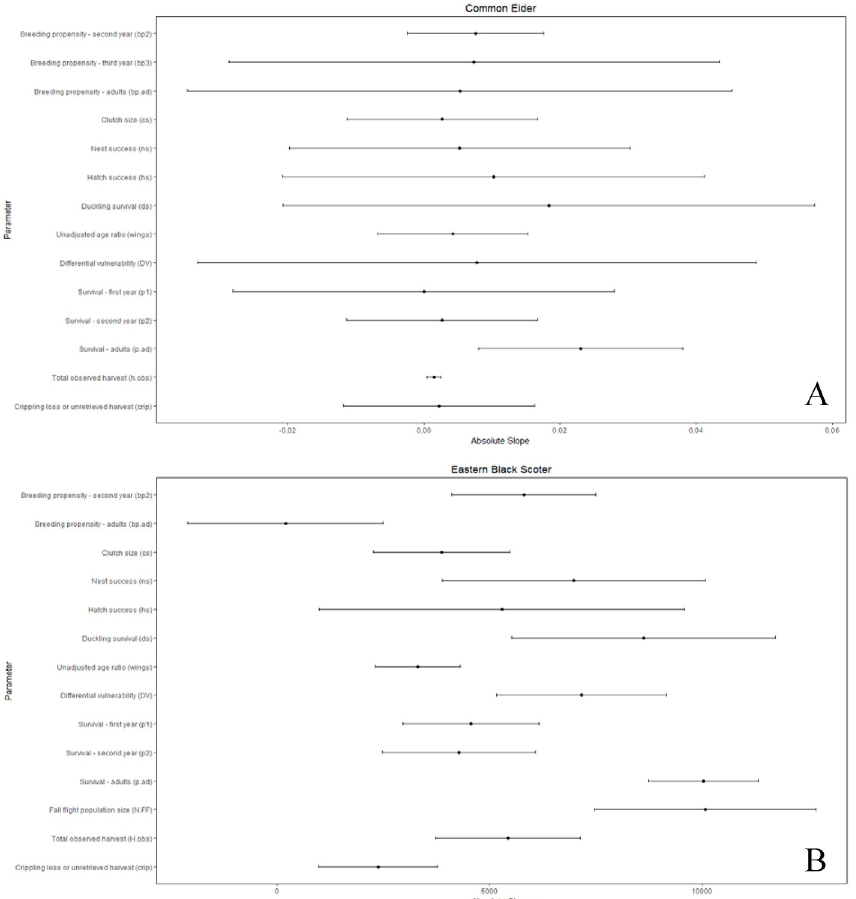
Fig 3. Sensitivity of the difference between allowable and observed harvest to individual demographic parameters as measuredby the slope of linear relationships between the harvest difference and standardized values of the demographic parameters, where greater absolute slope indicates higher sensitivity. Slope is affected by both the inherent sensitivity of growth rate and, hence, allowable harvest, to each parameter and its relative proportional uncertainty. Bars reflecting relative proportional uncertainty represent the coefficient of variation for non-binomial parameters or concentration for binomial parameters and, in both cases, have been multiplied by 100 (divided by 1000 for eiders) for scaling and presentation purposes. (A) common eider, (B) eastern black scoter.